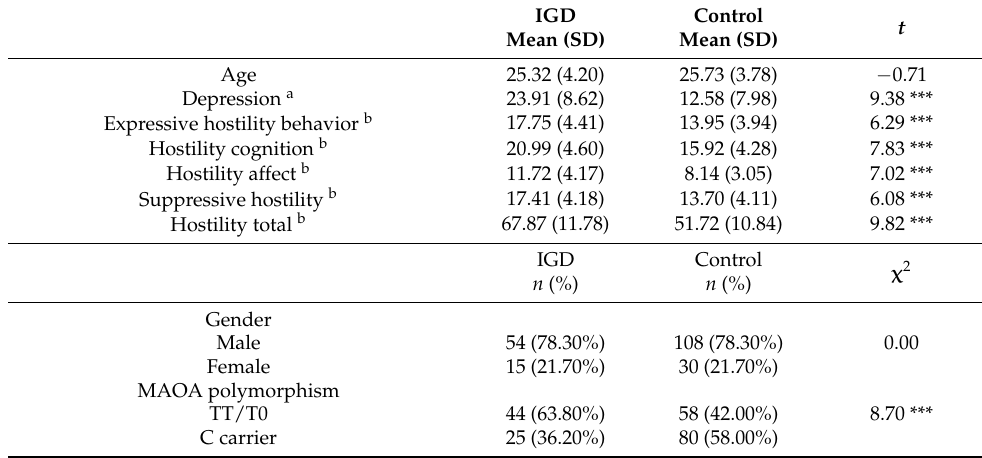
Table 1. Age, sex, depression, and hostility scores, and MAOA EcoRV polymorphism of the IGD group and controls.